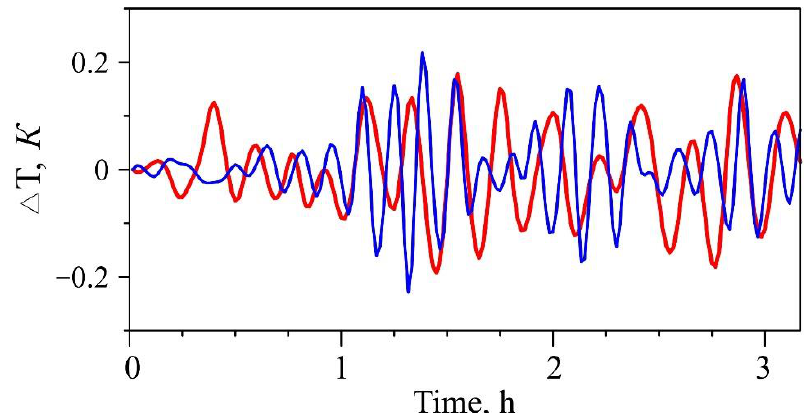
Figure 9. Temperature variations at an altitude of 150 km (blue line) and 230 km (red line) above the source. The initial moment corresponds to the start time of calculations.